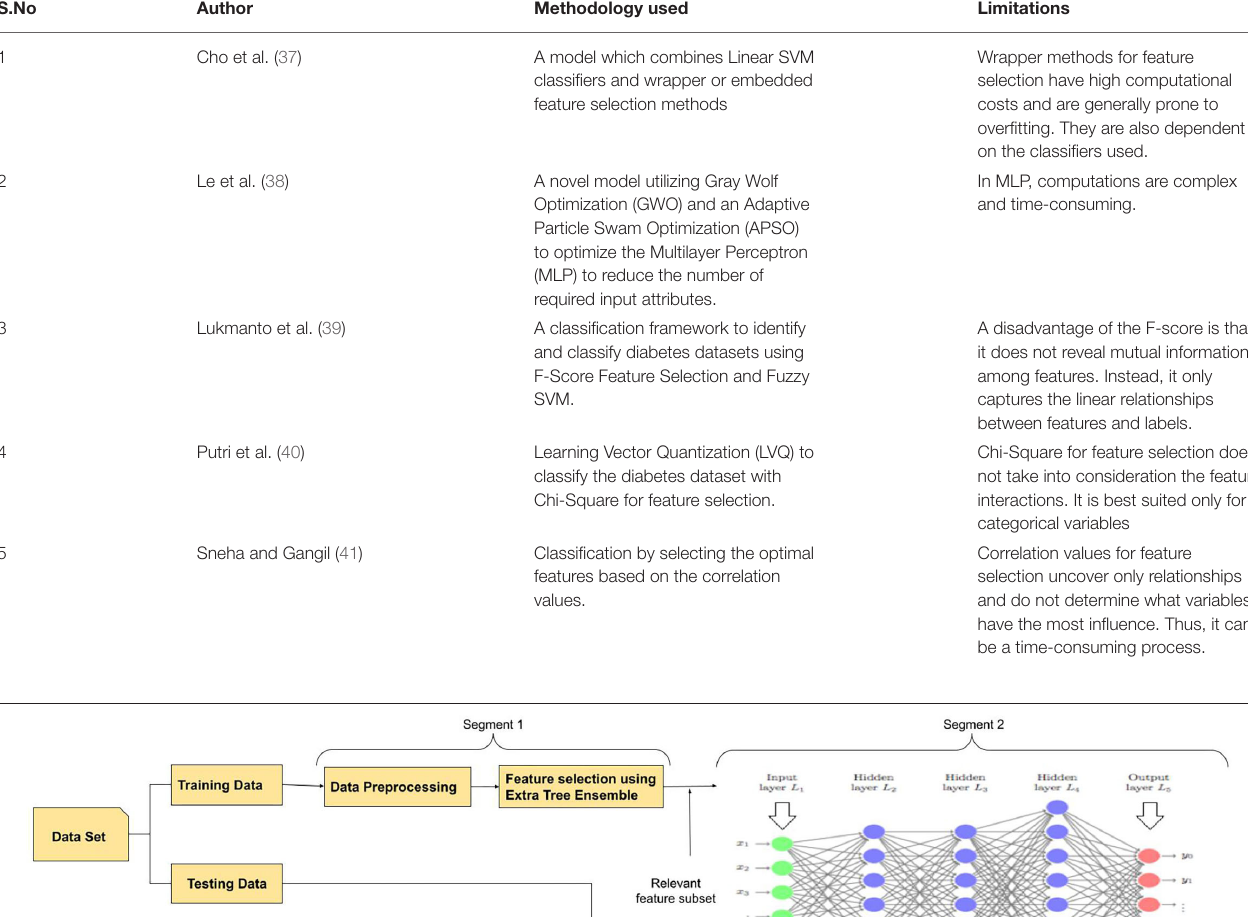
TABLE 1 | Methodology and limitations of recent relevant work.